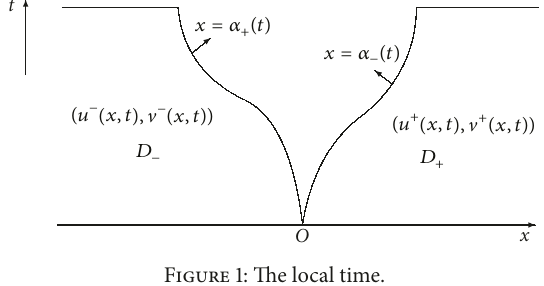
Figure 1: The local